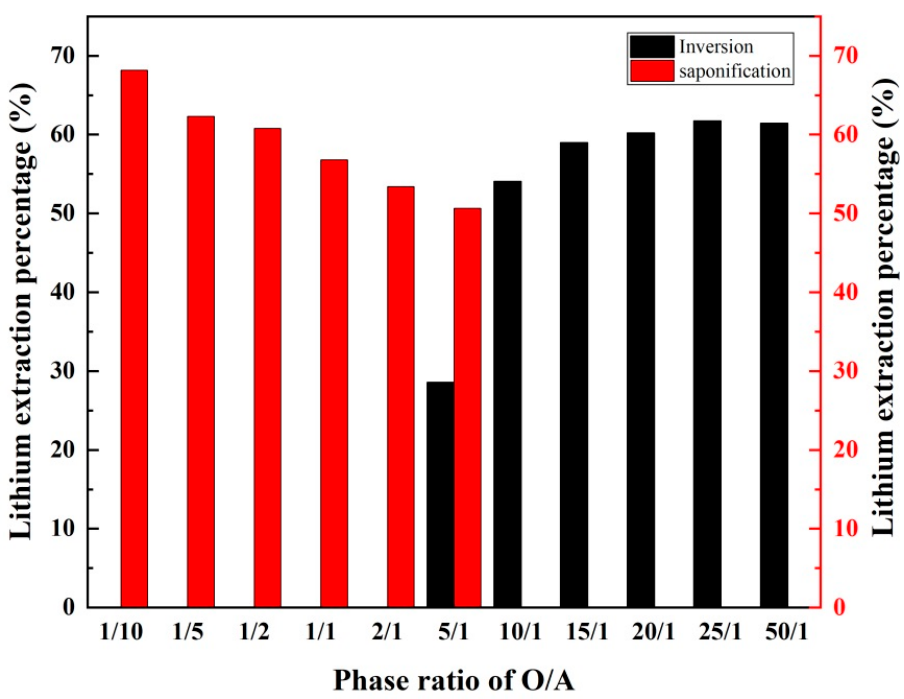
Figure 8. Effect of regeneration phase ratio.